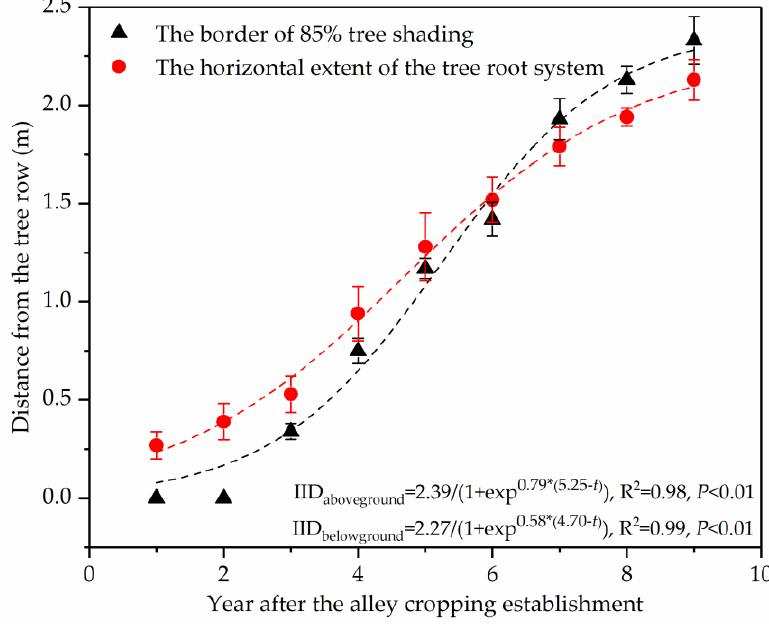
Figure 2. Trajectories of the border of 85% tree shading and horizontal extent of the tree root system in the apple monoculture system. The values of the scatter points were measured in Exp.1.